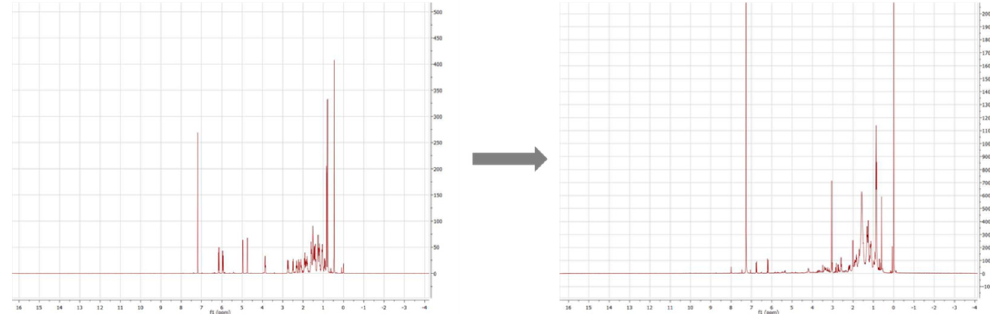
Figure 7. Comparison of 1 H-NMR spectra of a commercially-available cholecalciferol reference (left) and the product CC1 (right).